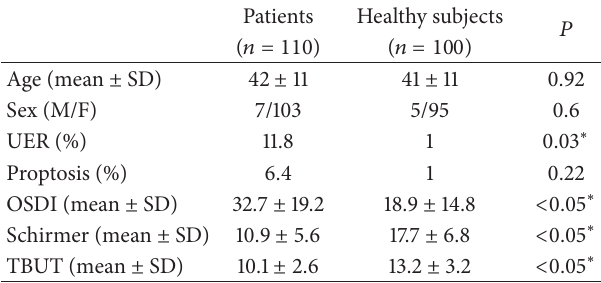
Table 2: Characteristics of patients and healthy subjects. Patients